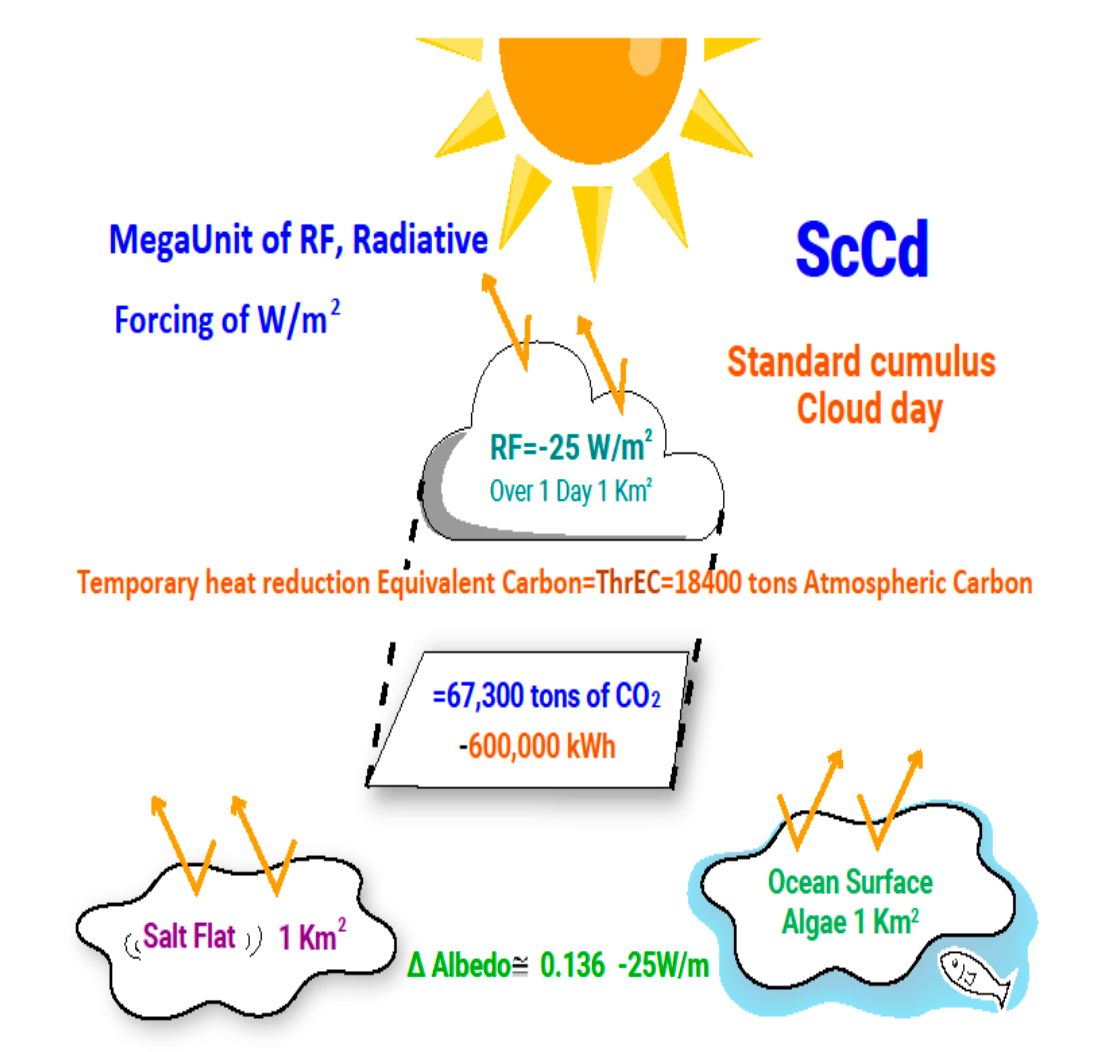
Figure 3. Estimating AE values from land (such as salt flats), marine cloud brightening (MCB), or near-surface algae creation (AEfACL).